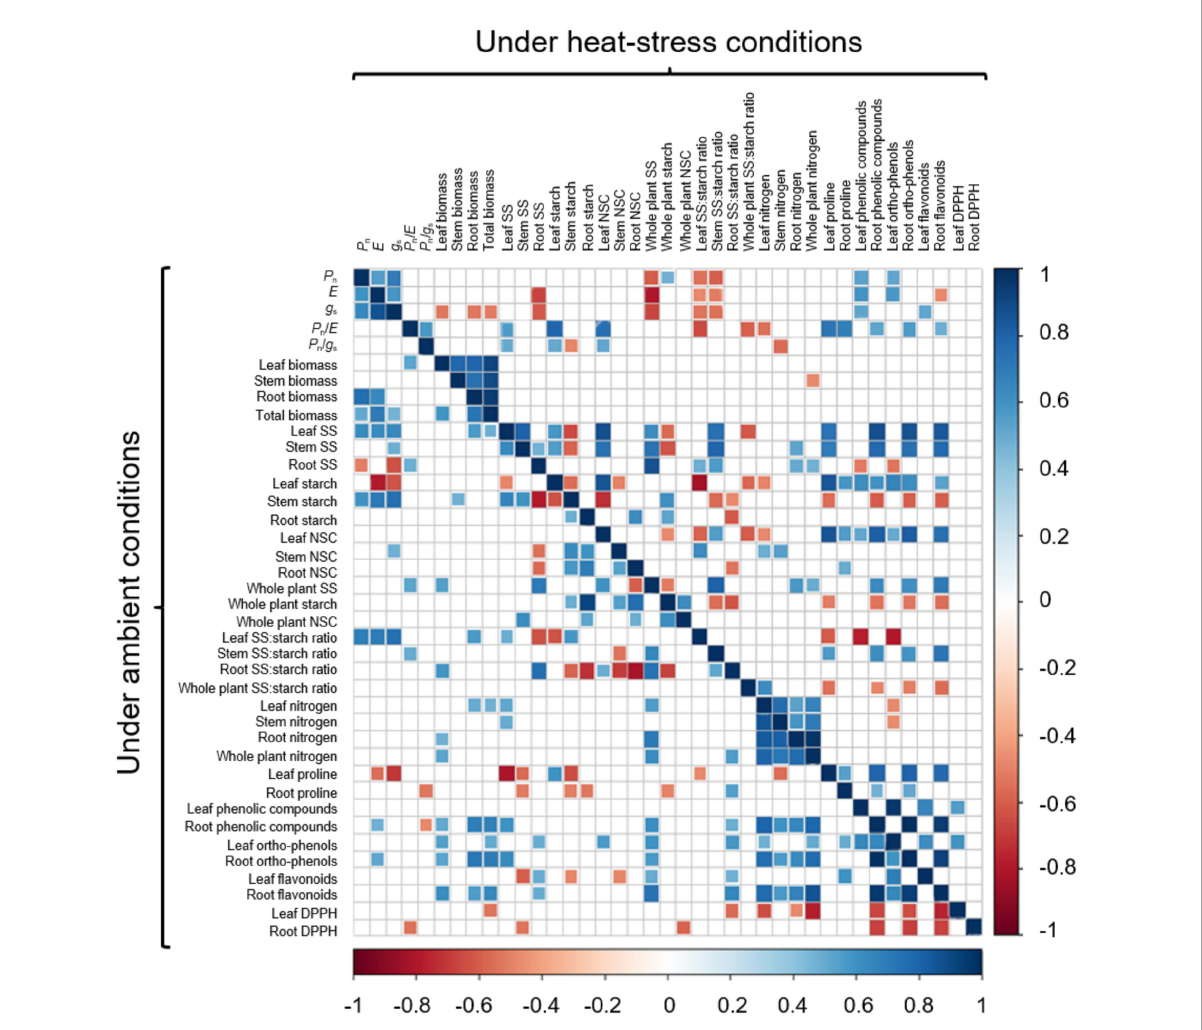
FIGURE5 Matrix of significant ( P < 0.05) Pearson correlation coefficients between gas exchange parameters, plant biomass, NSCs, nitrogen and proline content, total phenolic compounds, ortho-phenolic and flavonoid compounds and 2,2-diphenyl-1-picrylhydrazyl (DPPH) free radical scavenging of 6-month-old Castanea sativa seedlings subjected to ambient (below the main diagonal) and heat-stress conditions (above the main diagonal). Colored correlations are significant. Color gradient from blue to red indicates the gradient from positive to negative correlation